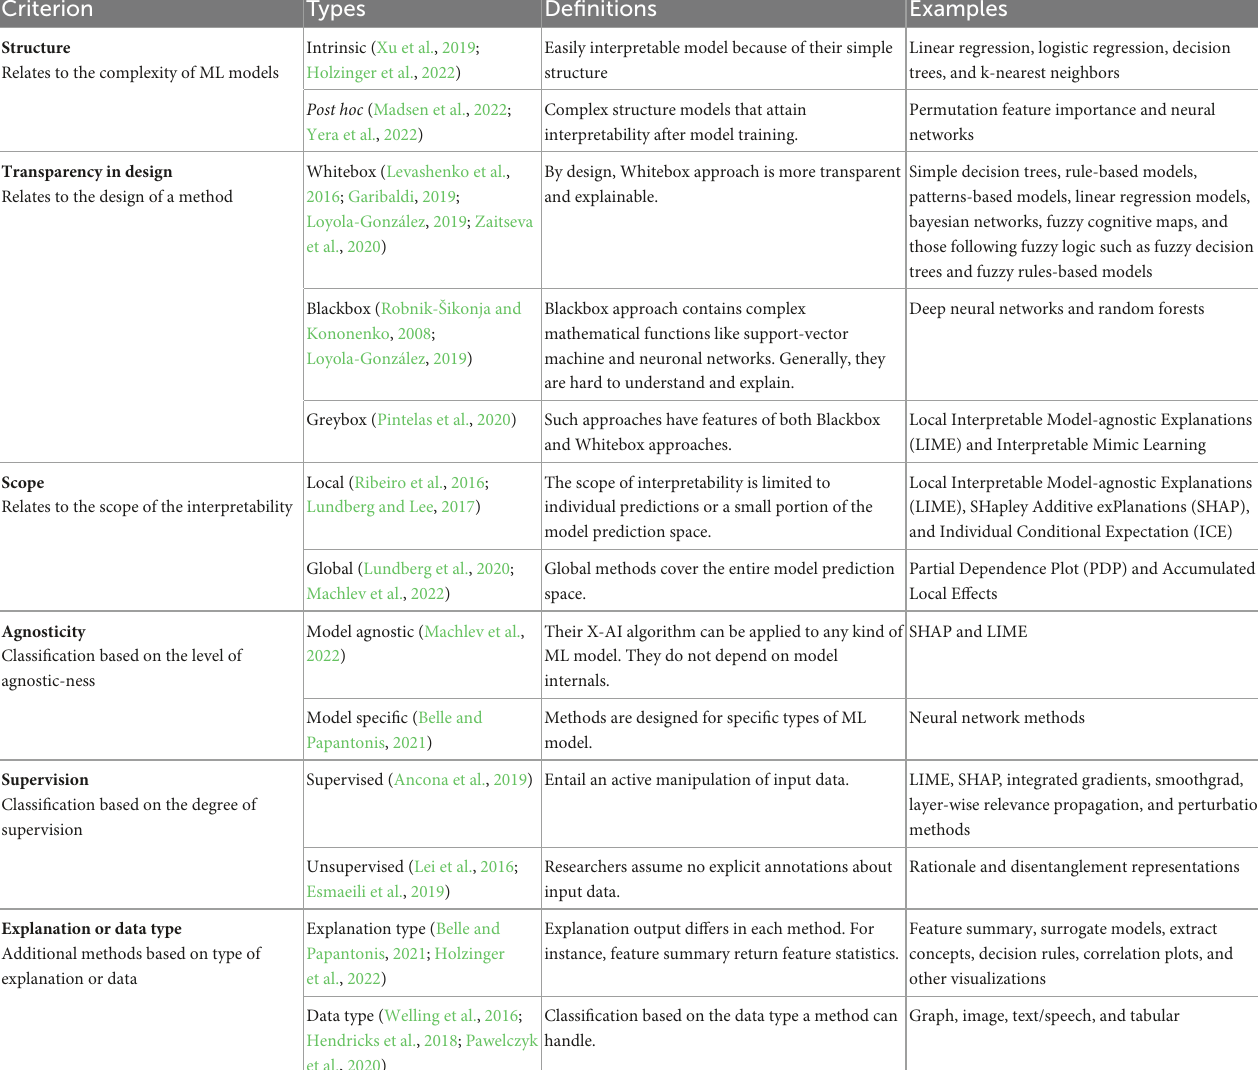
TABLE 1 Summary of existing explainable AI (X-AI)